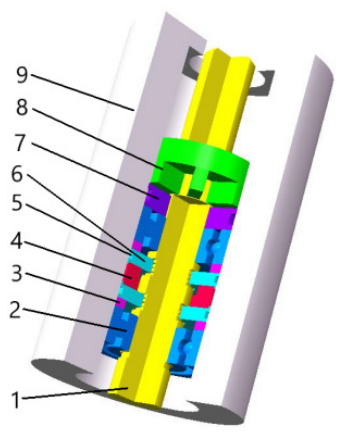
Figure 5. Schematic diagram of the combined magnetic fluid seal and back seal: 1—shaft, 2—bearing, 3—magnetic isolation ring, 4—permanent magnet, 5—O-shaped rubber rings, 6—pole pieces, 7water-stop sheet, 8—back blade seal, and 9—shell.